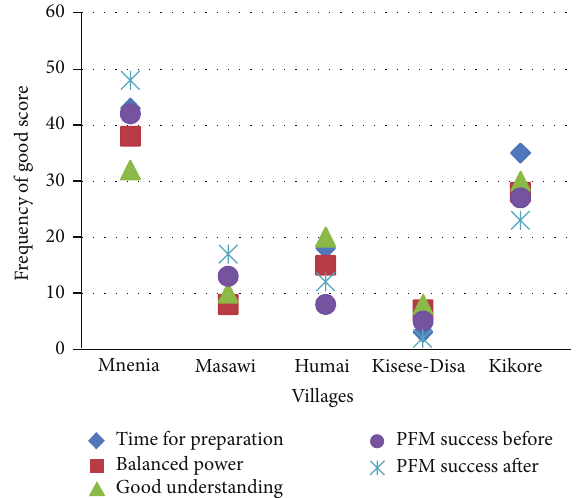
Figure 2: Comparison of perceived success of PFM before REDD+ and with REDD+ pilot project under different status of time for preparation; balanced power; good understanding of the pro-